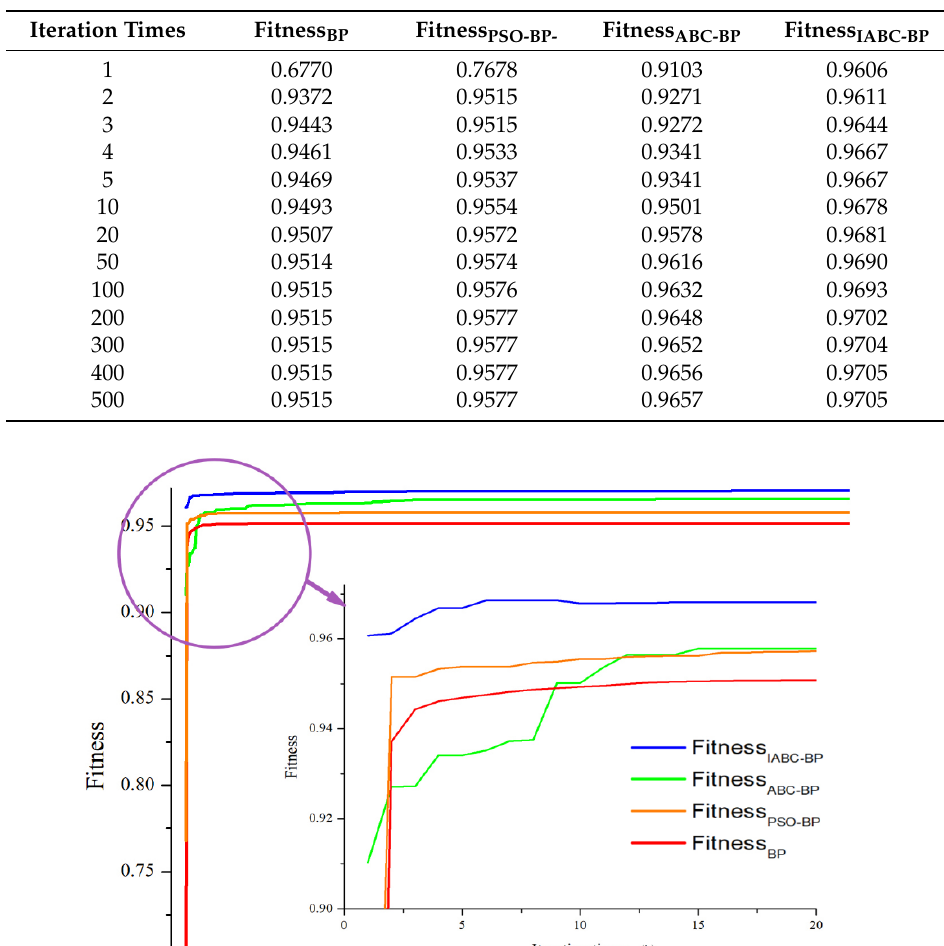
Table 3. Performance of convergence of each model.